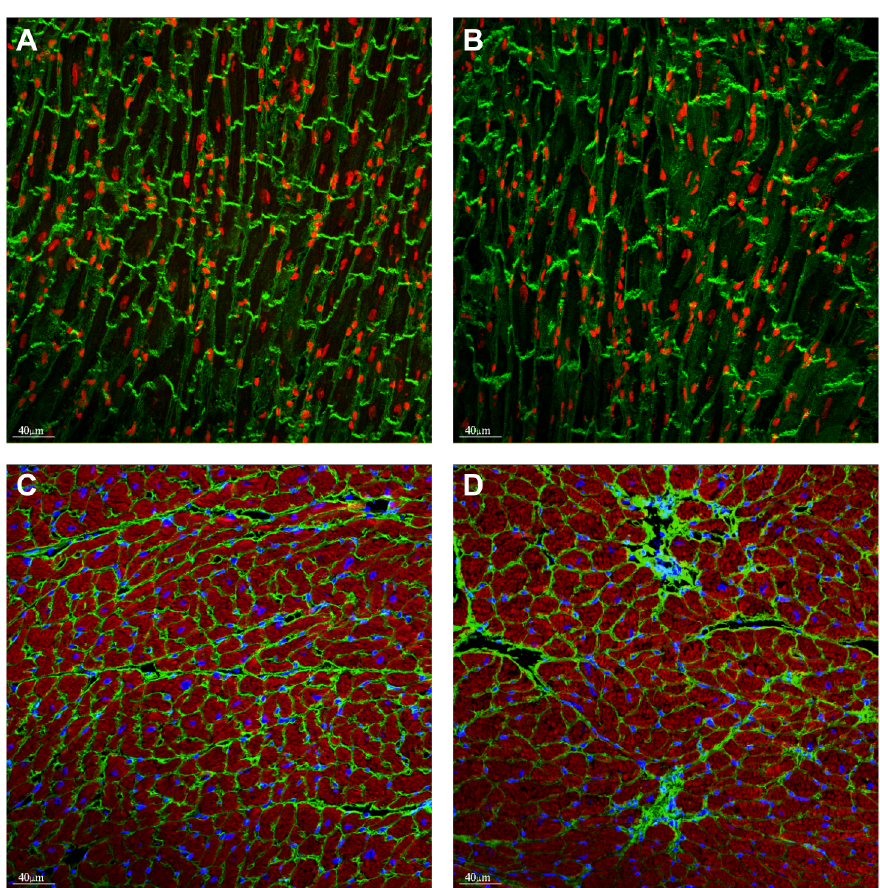
Fig 2. Gross cardiac morphology of hearts treated with doxorubicin. Representative vinculinstaining (green)in WT (PBS) mice (A) and WT doxorubicin(B). Nuclei (red) were visualizedwith draq5. Replacement fibrosis was detected in the doxorubicin treated hearts (D) but not in vehicle hearts (C), visualisingwith the anti-collagen VI antibody (green). Nuclei (blue) were visualisedwith DAPI, (E, F).